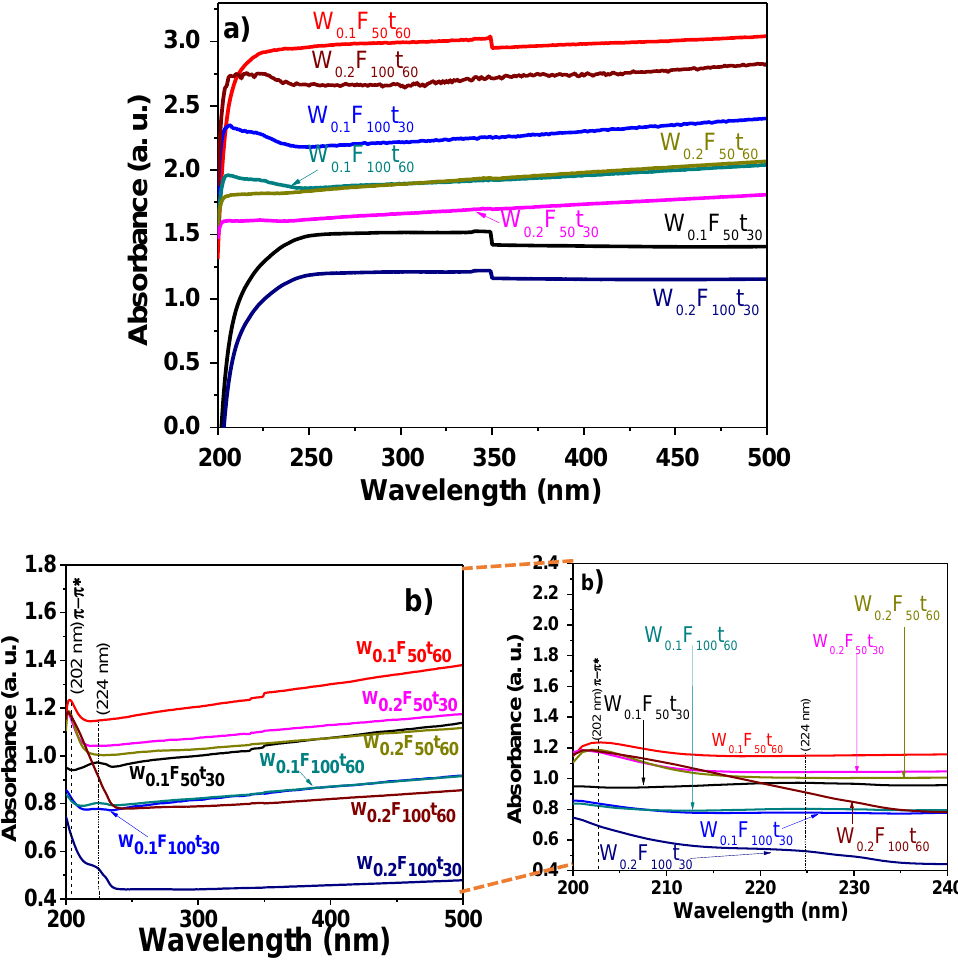
Figure 3. UV-Vis spectra of MWCNTs synthesized at 1123 K with different precursor amounts, reaction times, and argon flow rates: ( a ) before purification; ( b ) after purification with 3 M HCl + 30 vol.% H 2 O 2 with a magnification between 200–240 nm.